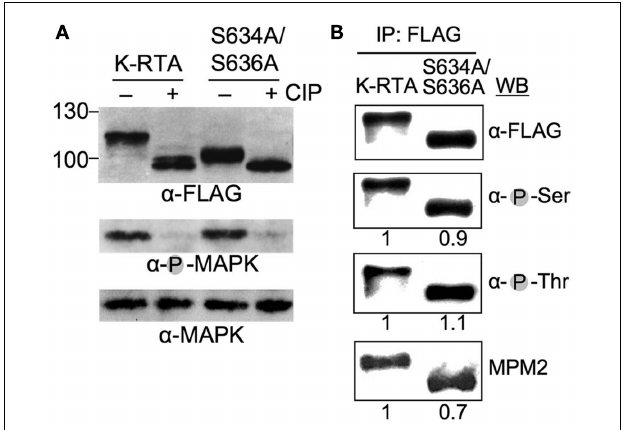
FIGURE 4 |The 10-kDa difference between K-RTA and S634A/S636A is not due to distinct global phosphorylation state. (A) Protein extract from HEK293 cells transfected with plasmids expressing K-RTA or S634A/S636A for 24h was incubated with ( + ) or without ( − ) calf intestinal phosphatase (CIP) at 37˚C for 45min. Each reaction mixture was analyzed in parallel byWestern blot analysis using specified antibodies. Phosphorylated MAPK served as a control for completeness of CIP treatment. (B) The overall Ser phosphorylation ( α -pSer),Thr phosphorylation ( α -pThr), and MPM2 reactivity of K-RTA and S634A/S636A were revealed by immunoprecipitation (IP)-Western blot analysis. Because the expression abundance of each species were varied, the intensity of each band was first normalized with the intensity of its corresponding FLAG polypeptide ( α -FLAG), followed by comparing to the normalized K-RTA value that was set to